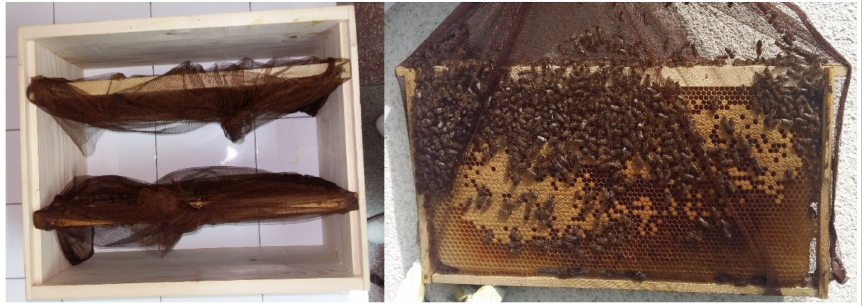
Figure 1. Frames with sealed brood placed in net bags [27].